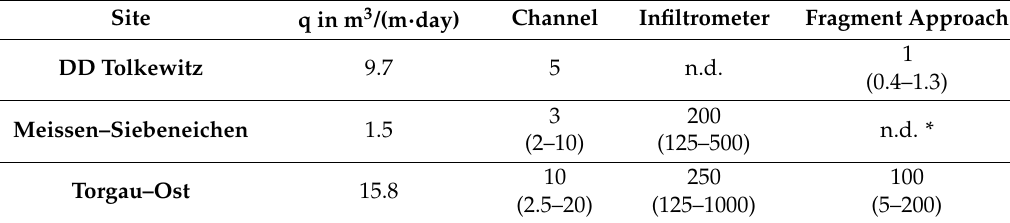
Table 2. Mean values for L in 10 − 6 s − 1 at riverbank filtration sites along the upper Elbe River, 1991–1993